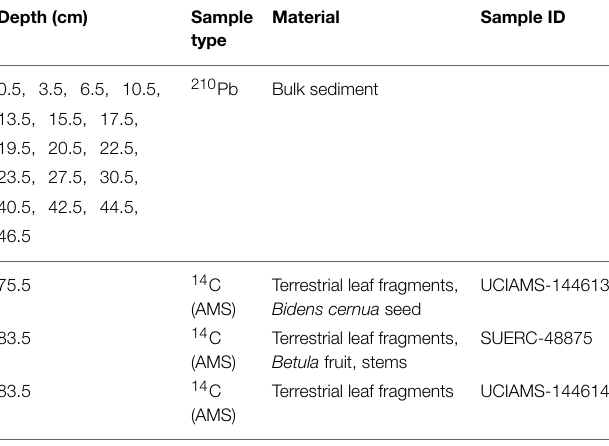
TABLE 1 | Samples used to create the dating profile of CUNS2. Depth